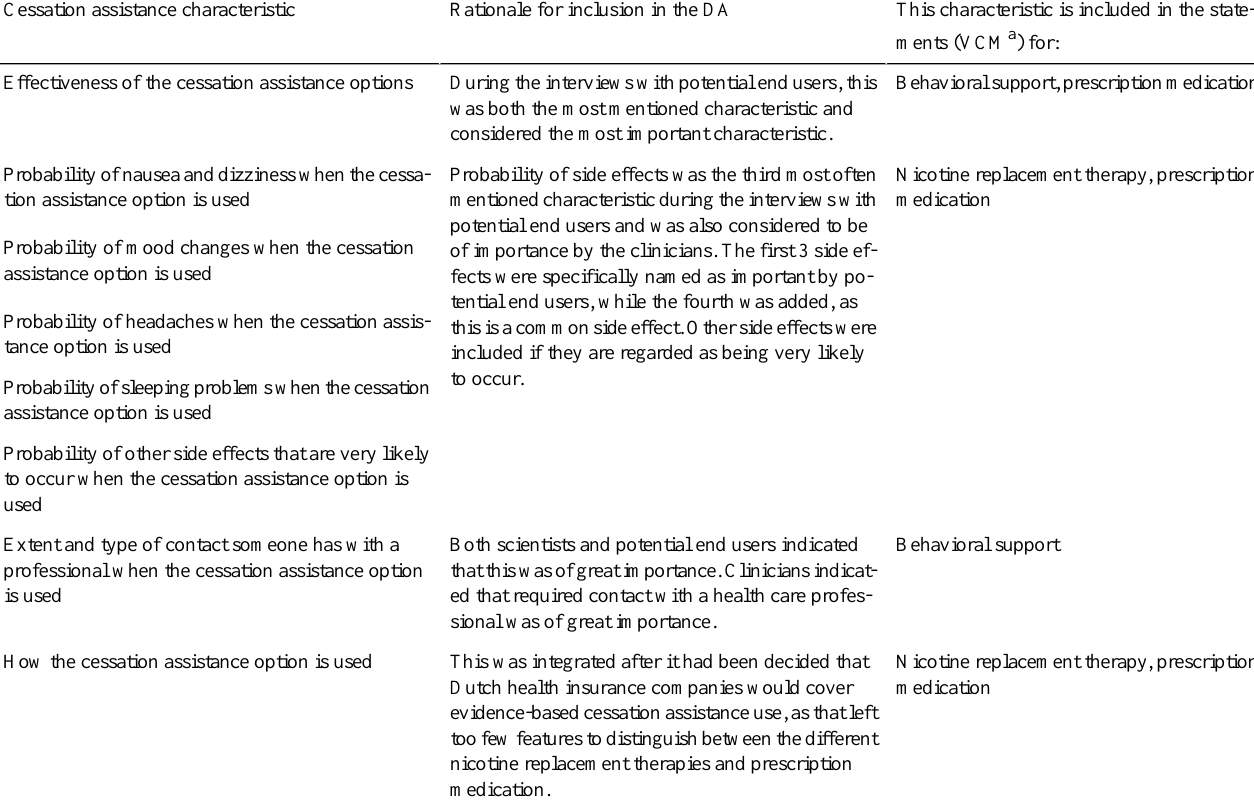
Table 2. Overview of cessation assistance characteristics included in the decision aid (DA).